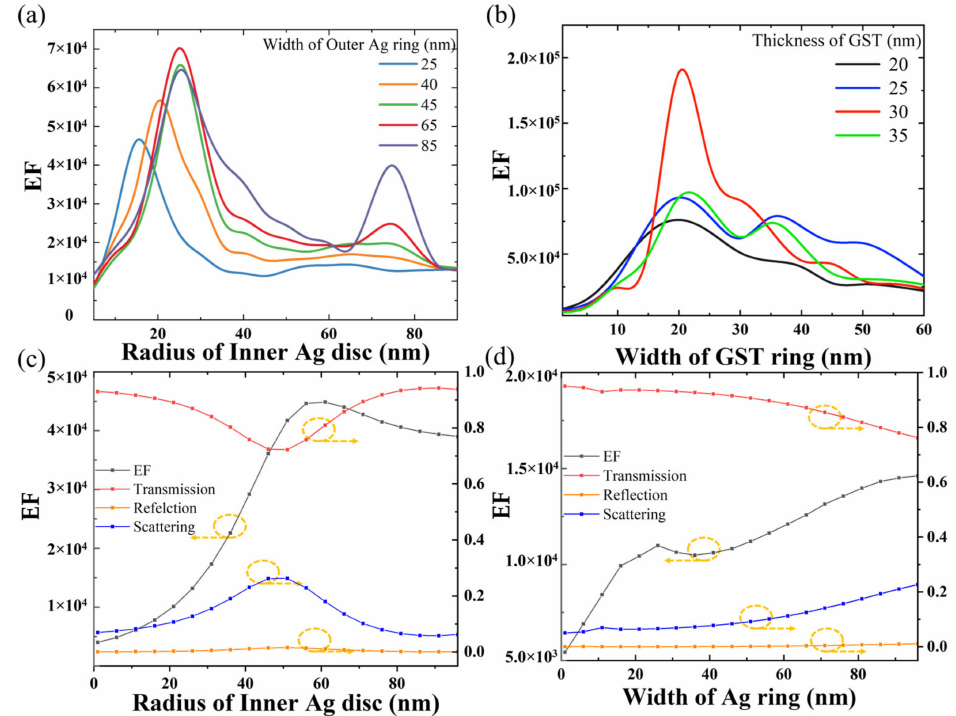
Figure 3. Dependence of enhancement factor on the geometry of the device. ( a ) Enhancement factor versus the radius of Ag nano-disc and width of Ag nanoring. ( b ) Enhancement factor versus width of GST nanoring and thickness of the whole structure. ( c ) Integrated nanoantenna optical properties versus the radius of Ag nano-disc and width of Ag nanoring ( d ) (note no GST is present here, the gap between the antennas is filled with air) Enhancement factor EF (left axis), transmission, reflection, and scattering (right axis) for a nanoantenna-only configuration, with disc thickness of 30